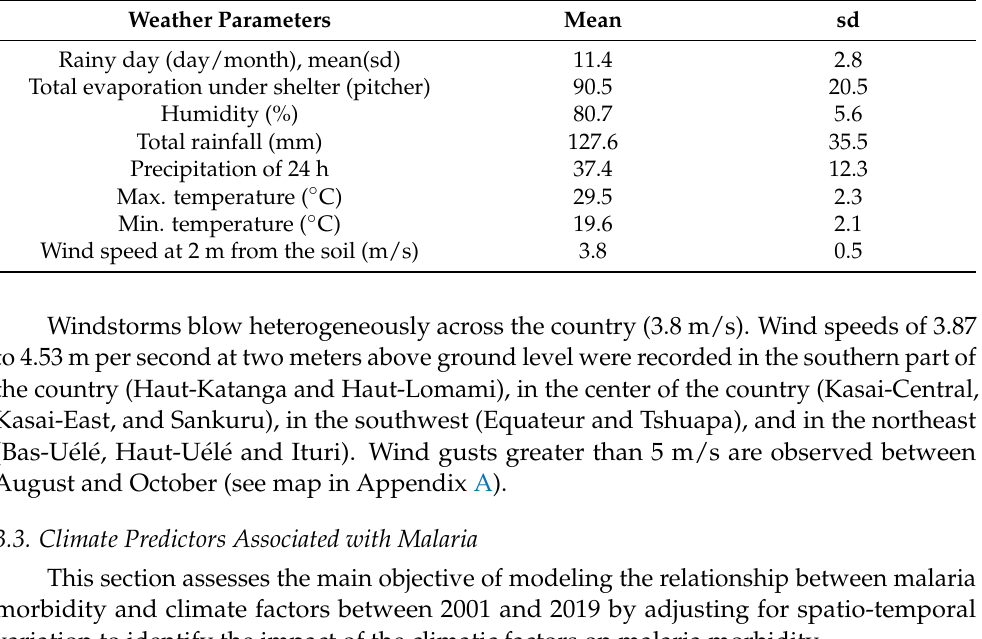
Table 3. Weather parameters in DRC, 2001–2019 (26 provinces xX 19 ans), n = 494. Weather Parameters Mean sd Rainy day (day/month), mean(sd) 11.4 2.8 Total evaporation under shelter (pitcher) 90.5 20.5 Humidity (%) 80.7 5.6 Total rainfall (mm) 127.6 35.5 Precipitation of 24 h 37.4 12.3 Max. temperature ( ◦ C) 29.5 2.3 Min. temperature ( ◦ C) 19.6 2.1 3.8